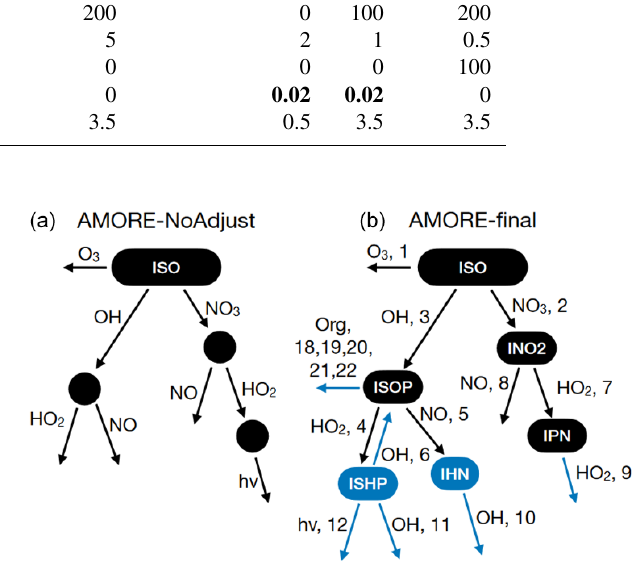
Figure 2. The original AMORE algorithmically generated mecha- nism prior to manual adjustment (a) and the final AMORE-Isoprene mechanism (b) . Changes are highlighted in